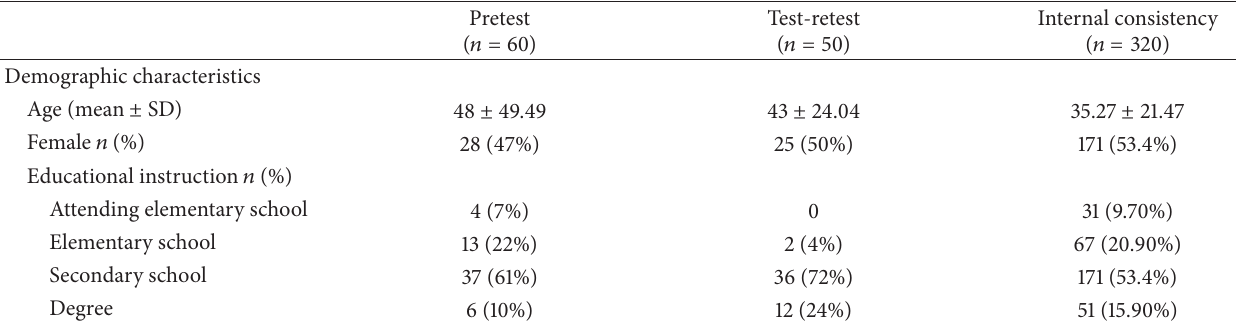
Table 1: Demographic characteristics of individuals submitted to each test.